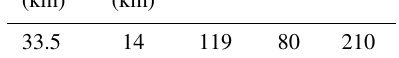
Table 1. The area and the focal mechanism of the PIF zone. These are the constant parameters during the MC simulation application. Fault Fault Strike Dip Rake length width (km) (km) 33.5 14 119 80